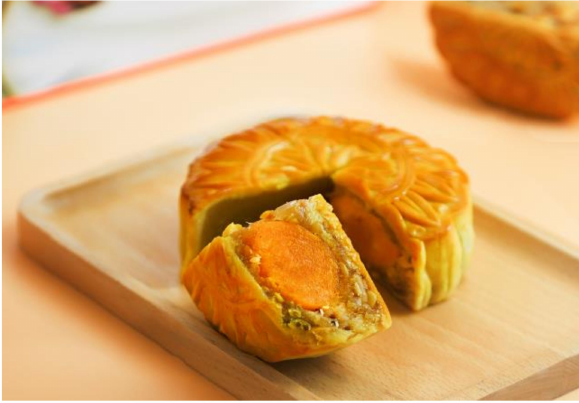
Figure 5. Yuebing. Source: Unplash. Moon cake